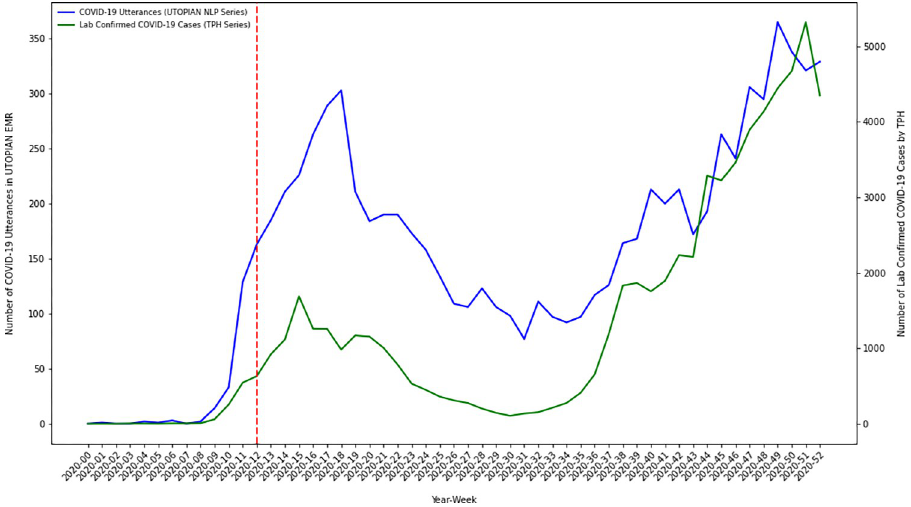
Fig 1. Time series plot of the composite count of the number of COVID-19 positive utterances from each of the three electronic medical record text streams (lab text, health condition diagnosis text and clinical notes) versus the number of lab confirmed COVID-19 cases in Toronto, Canada (data extracted from Toronto Public Health).